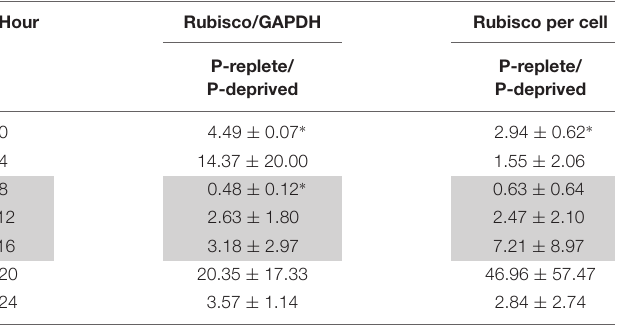
TABLE 2 | Ratios of Rubisco abundance (normalized to GAPDH and per cell) in P-replete group to that in the P-deprived group throughout the diel cycle (mean ± standard